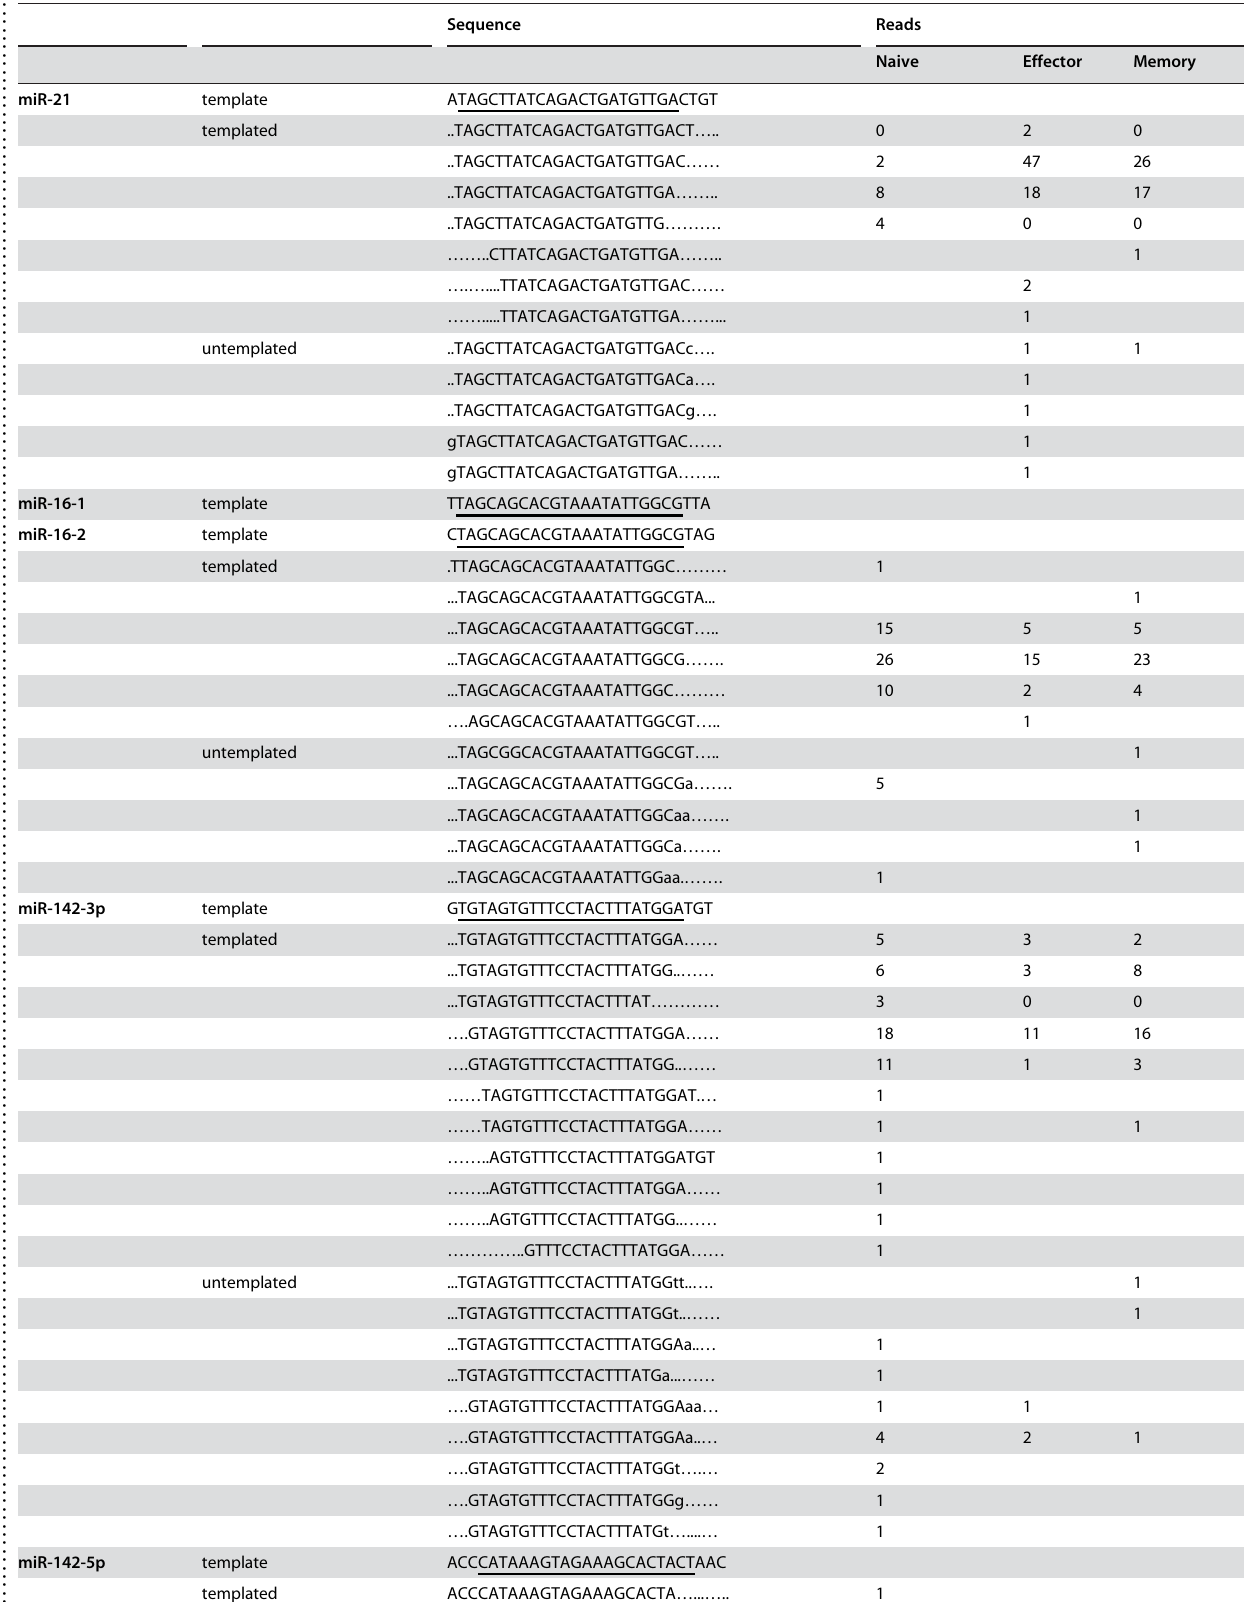
Table 1. Examples of miRNA end variations in the T cell subsets. .. ... .... ... ... .... ... ... .... ... ... .... ... ... .... ... ... .... ... ... .... ... ... .... ... ... .... ... ... .... ... ... .... ... ... .... ... ... .... ... ... .... ... ...